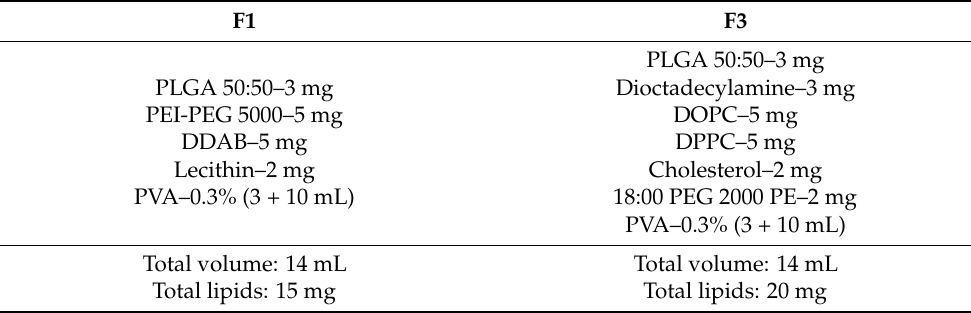
Table 1. Compositions F1 and F3 delivery systems.